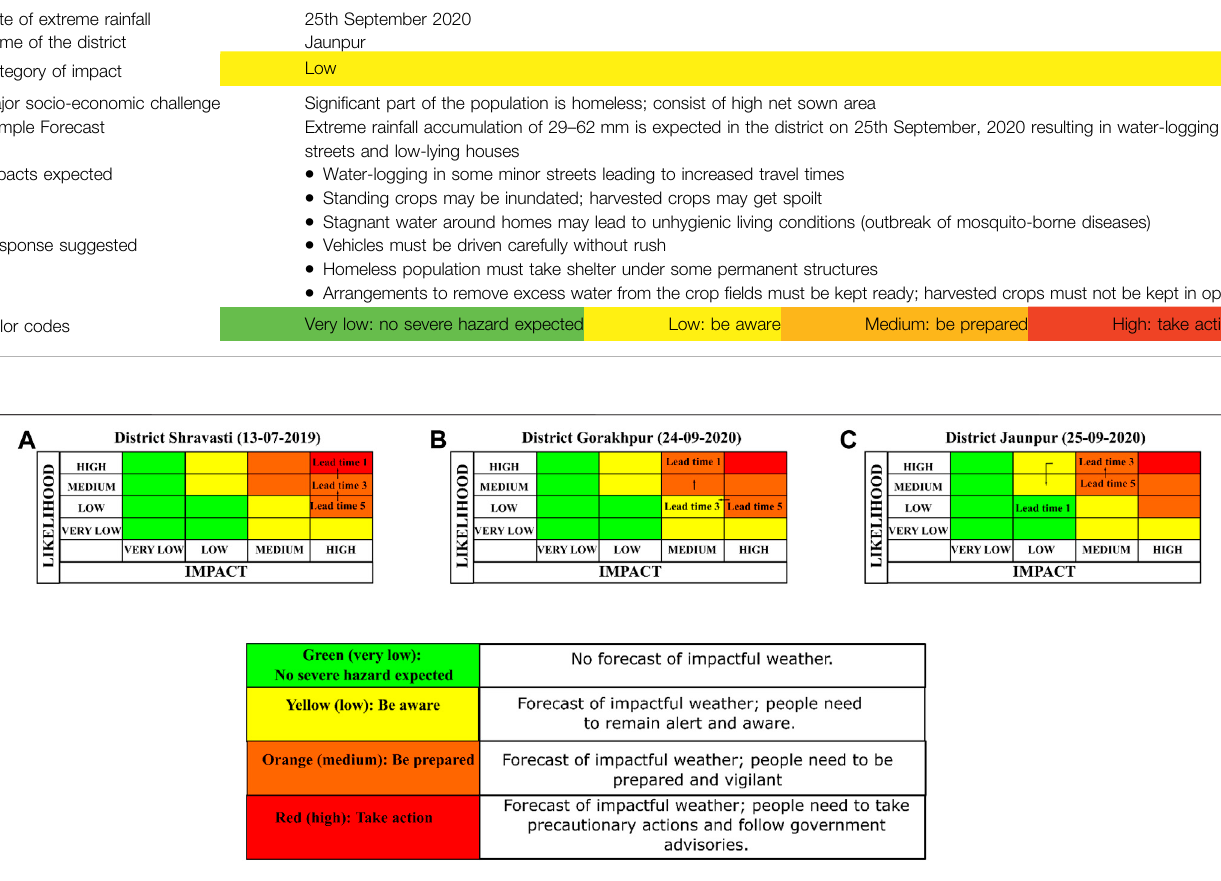
Frontiers in Earth Science |